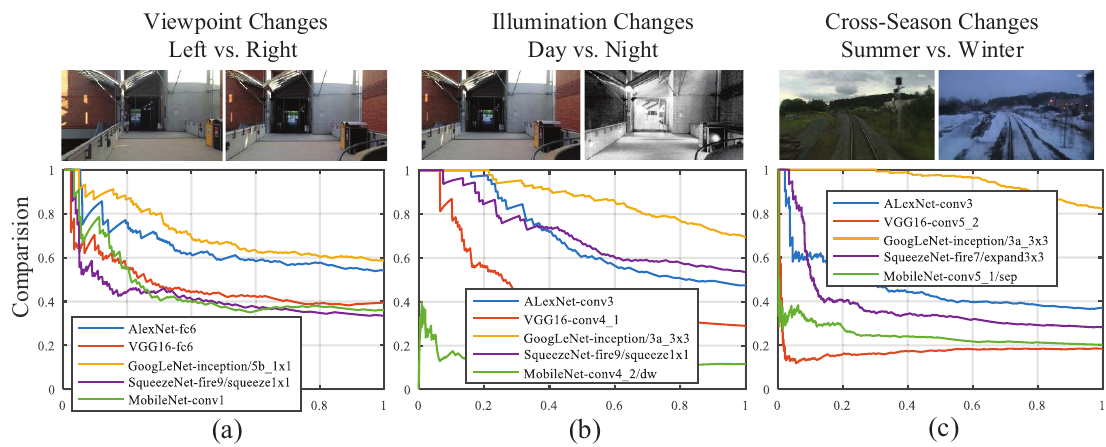
Figure 14. Precision–Recall curves comparing between the best result selected from each ConvNets on different datasets: ( a ) comparison results about left vs. right in Gardens Point dataset; ( b ) comparison results about day vs. night in Gardens Point dataset; and ( c ) comparison results about summer vs. winter in Nordland dataset. Table 1. The performance of state-of-the-art ConvNets trained on ImageNet [41] datasets and the assessment on three aspects. The bold and italic items denote the